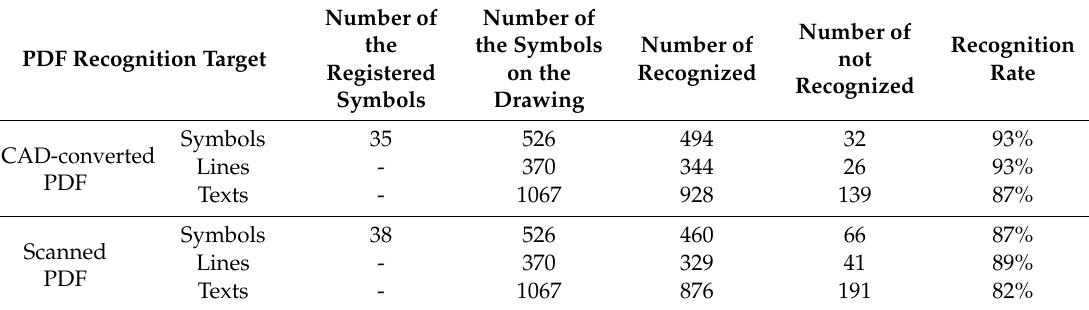
Table 1. The results of recognizing imaged P&IDs in